Question: What caption would you write for this figure?
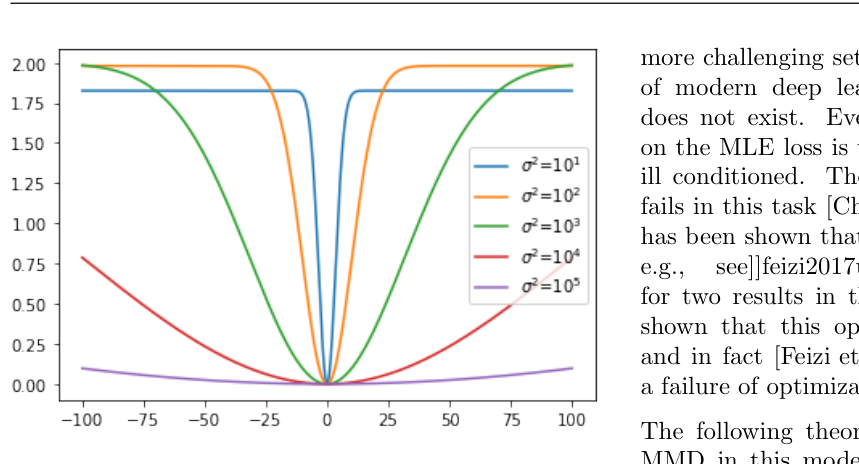
Answer: MMD loss of Gaussian over R with unknown mean. Different widths σ2 and µ∗= 0.